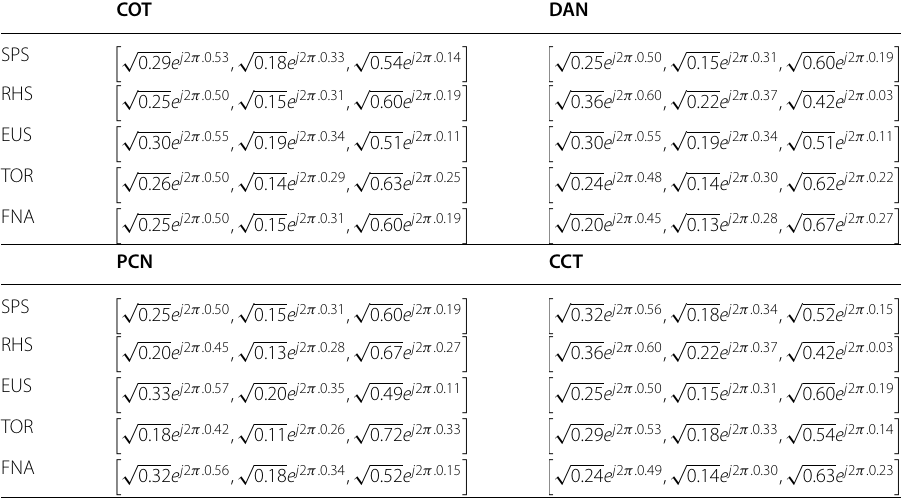
Table 11 Average values of quantum spherical fuzzy numbers for the components COT DAN SPS